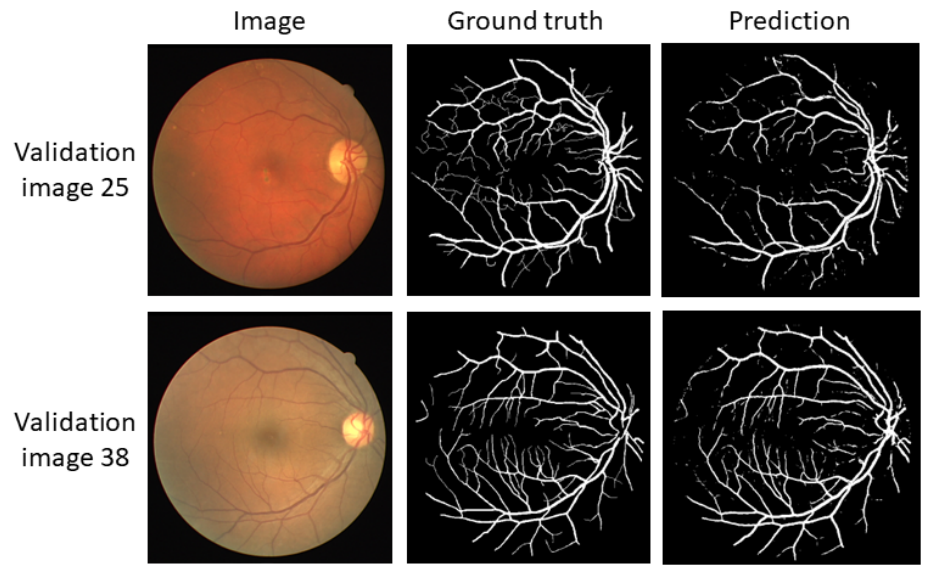
Figure 5. Two validation images, its real mask and the UNETR